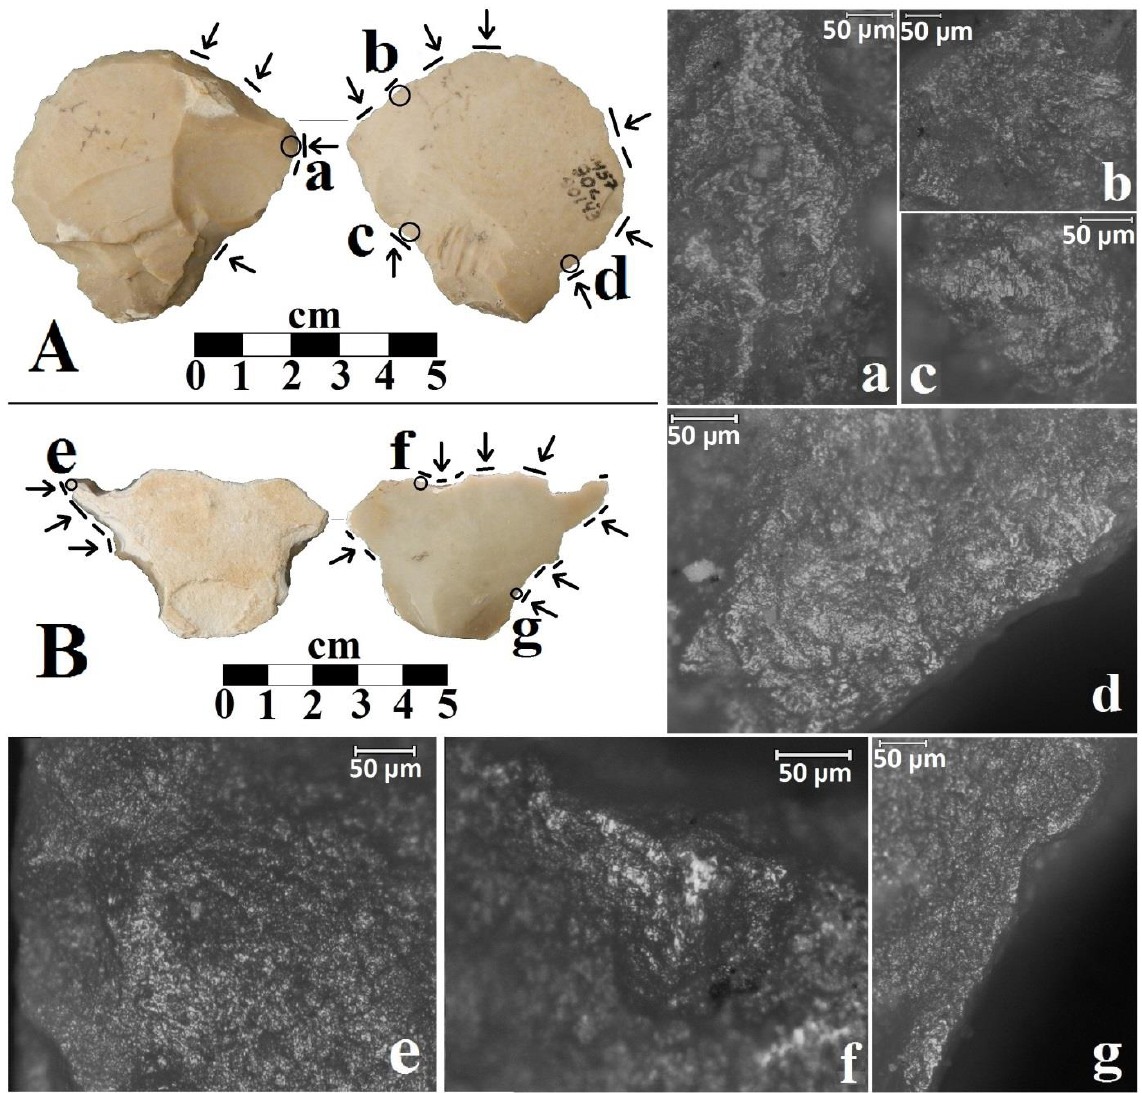
Figure 4. CFS fan scrapers ( A , B ) used for butchering and skinning that were notched and used to scrape meat off bones or manufacture bone tools. a , b , e : rough “greasy” meat or fresh hide polish on edges used for butchering and skinning. c , d , rough “greasy” polish in notches of A . f , g : bright bone polish in notches of B . A : Dorsal (left) and ventral (right) faces of MW#15, round fan scraper, Area C, late PN layer, Locus 9029, Bucket 90143. B . fan-shaped scraper (MW#21, Area N, EBA layer, Locus 7701, Bucket77010. White lines show extent of usewear, arrows show orientation of microwear polishes and striations, circles show locations of microphotographs a - g . All photomicrographs are 187.5x, scales are 50